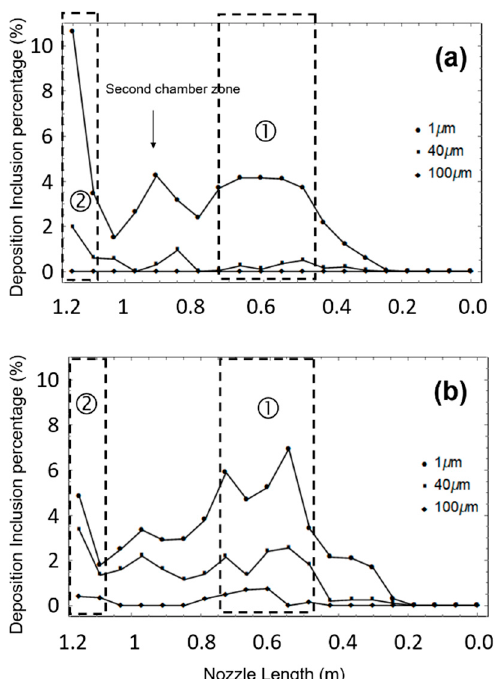
Figure 11. Deposition inclusion percentage as function of the nozzle length for three inclusion sizes